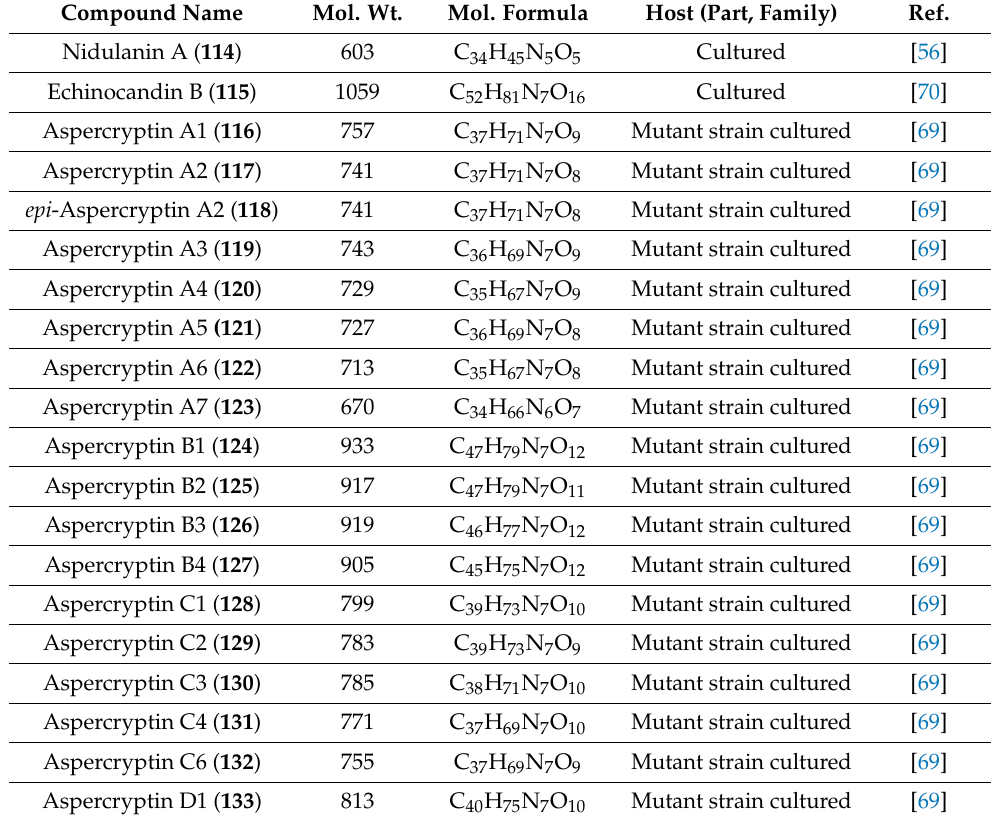
Table 9. Peptides reported from A. nidulans